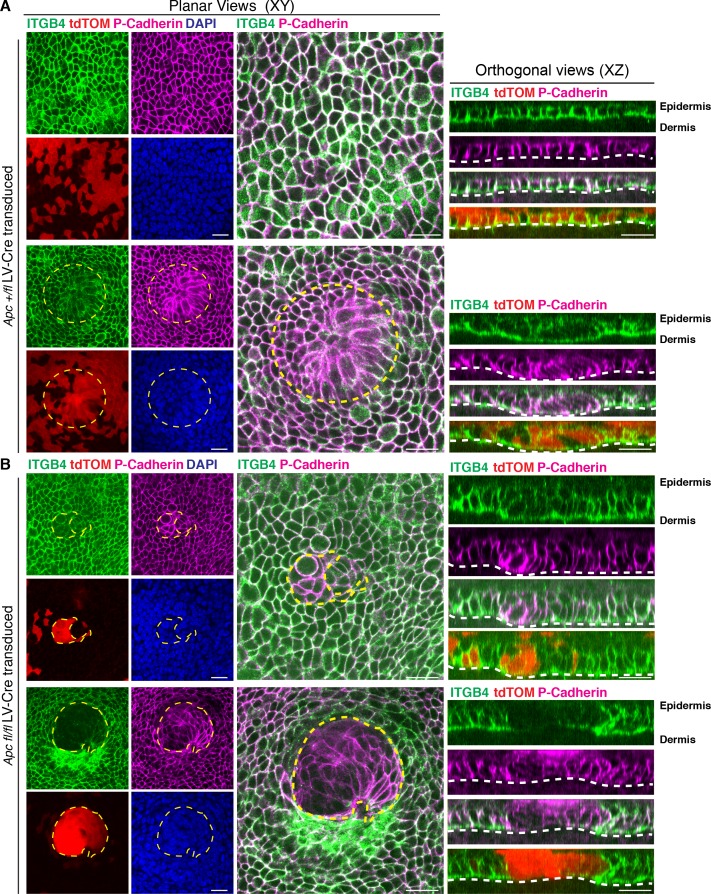
Apc-null cell clusters lose the hemidesmossome integrin beta4 (ITGB4).Representative E14.5 whole-mount immunofluorescence images and respective orthogonal views from (A) Apc-het and (B) Apc-null transduced tdTomato+ embryonic skins showing endogenous ITGB4 and P-Cadherin staining. Note the loss of ITGB4 in Apc-null clusters when compared to the surrounding wild-type skin. Circular yellow dashed line outlines a heterozygous placode while remain dashed lines contour Apc-null cell clusters. White dashed lines demarcate epithelial-mesenchymal boundaries. The XY axis is planar to the epidermis; the XZ axis shows sagittal views perpendicular to the skin surface. Scale bars, 20 μm.